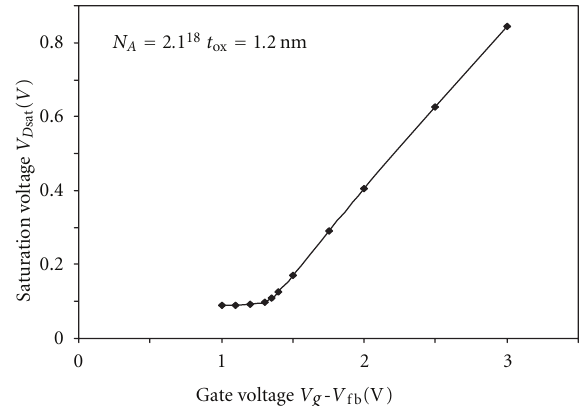
Figure 10: The saturation voltage V D sat versus Vg . ( L = 90nm; W/L = 10.)